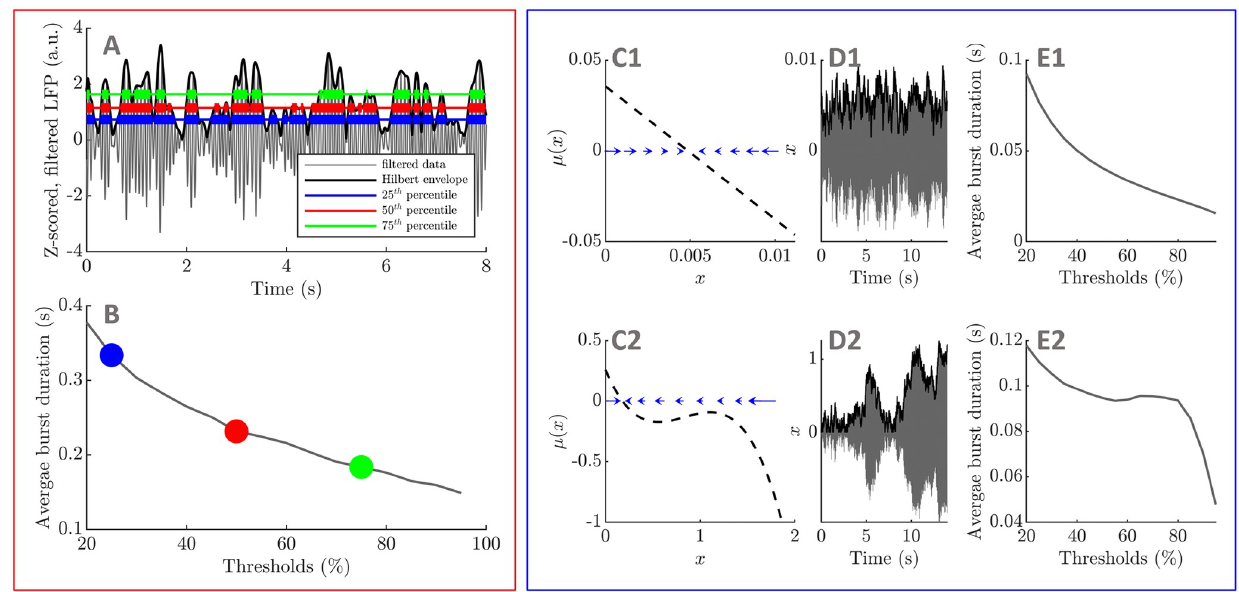
Fig 1. Introducing average burst duration profiles. Average burst duration profiles are obtained by computing beta envelope average burst duration for a range of thresholds. An example is provided for three thresholds, where thick lines highlight the duration of individual bursts for the three thresholds in panel A, and the corresponding averages are identified with the same colour in panel B. Considering the time discretization of simple envelope models of the form dx = μ ( x ) dt + z dW , where μ is the drift function, W is a Wiener process, and z is a constant noise parameter, we illustrate with two example drift functions the link between envelope dynamics (panels C1 and C2, one-dimensional vector field also sketched with blue arrows) and average burst duration profiles (panels E1 and E2). The envelope models produce the black envelopes in panels D1 and D2, and beta oscillations (shown in grey in panels D1 and D2) can be obtained by adding a constant frequency phase equation. In C1, when x moves away from the fixed point, it will be strongly attracted back. By contrast, in the case of C2, if x is around 1, there is weak attraction towards the fixed point, allowing x to stay at an elevated level for longer.